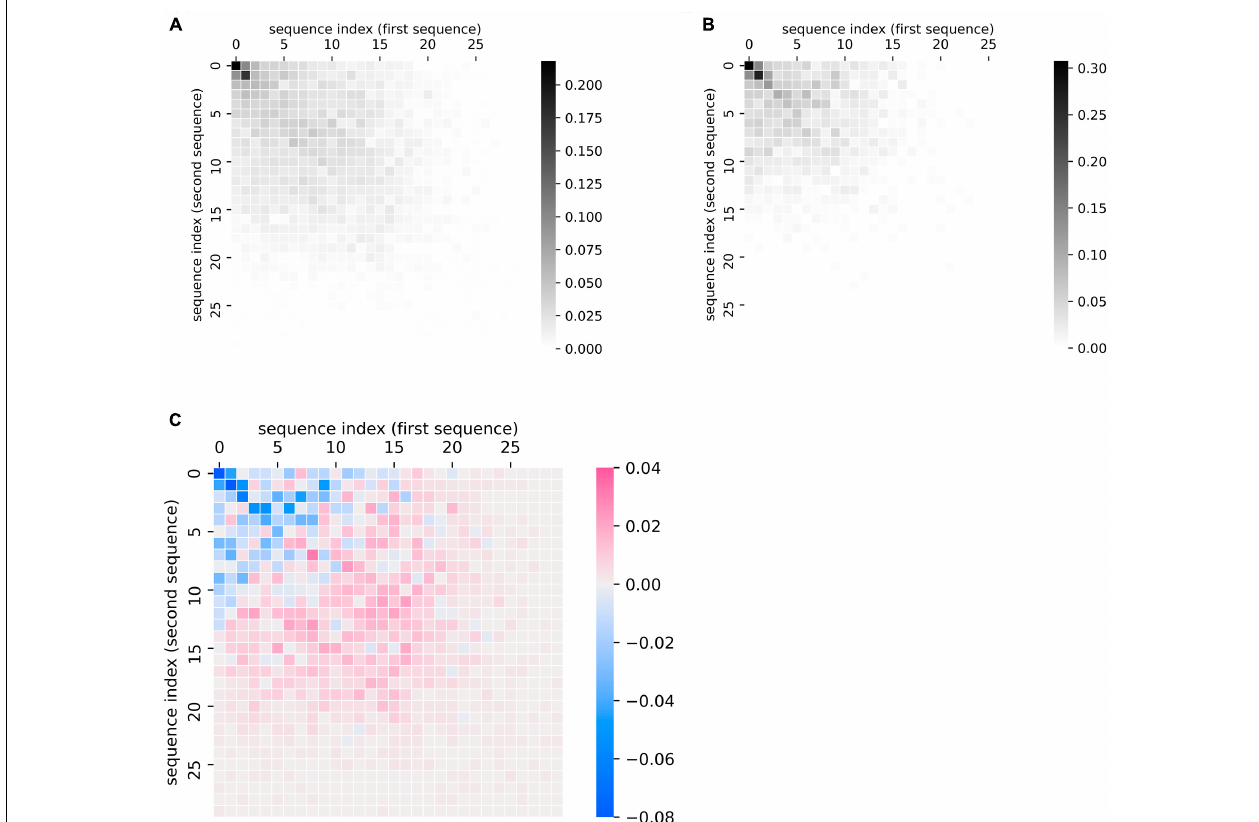
FIGURE 4 | Visualizing group-level comparisons of fluency data. (A) Cumulative plots of every chronologically adjacent pair of sequences (i.e., a sequence from one clinic visit paired with one from the next) from the same participant from visits where the participant was diagnosed as healthy control. Individual similarity matrices (where 1 indicates a position of overlap between the sequences and 0 indicates no overlap) are added together and then scaled (by dividing by the total number of matrices or plots in each group). Scale bar thus indicates the proportion of matrices where the indicated point overlaps between a participant’s two lists. n = 97 participants, 724 pairs of sequences. (B) Cumulative plots of every chronologically adjacent pair of sequences from the same participant from visits where the participant was diagnosed as Probable AD. Individual similarity matrices are added together and then scaled as described above. n = 61 participants, 221 pairs of sequences. (C) Subtraction of the cumulative scaled plot of healthy control participants (A) minus the cumulative plot of Probable AD participants (B) . Scale bar indicates how much more likely a point is to belong to the overall control (pink) or ProbAD (blue) group pattern. Pink areas correspond to relatively stronger healthy control patterns (controls tend to have more lists that overlap in these areas) and blue colors correspond to stronger Probable AD patterns (ProbAD participants tend to have more lists that overlap in these areas).